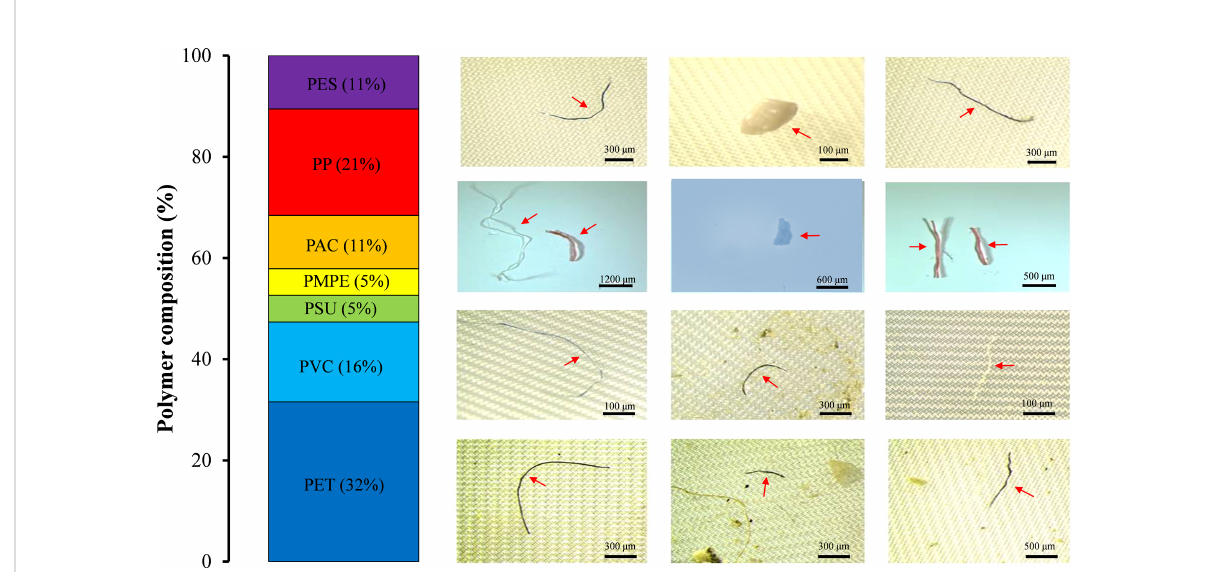
FIGURE 3 Polymer composition and the representative microplastics detected in marine fi sh samples from Beibu Gulf. PES, polyester; PP, polypropylene; PAC, polyacrylic; PMPE, poly methyl propenyl ether; PSU, polysul fi de; PVC, polyvinyl chloride; PET, polyethylene